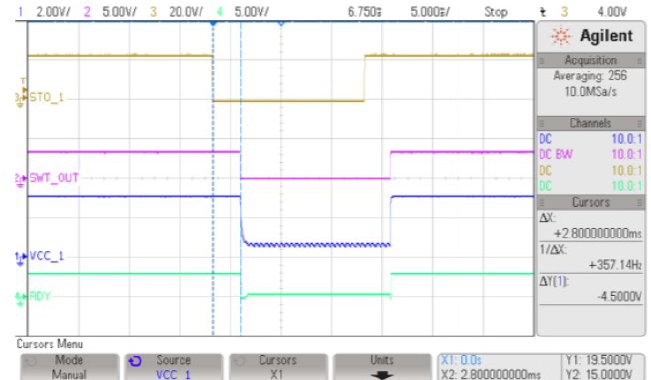
Figure 3. Propagation of STO1 to primary supply